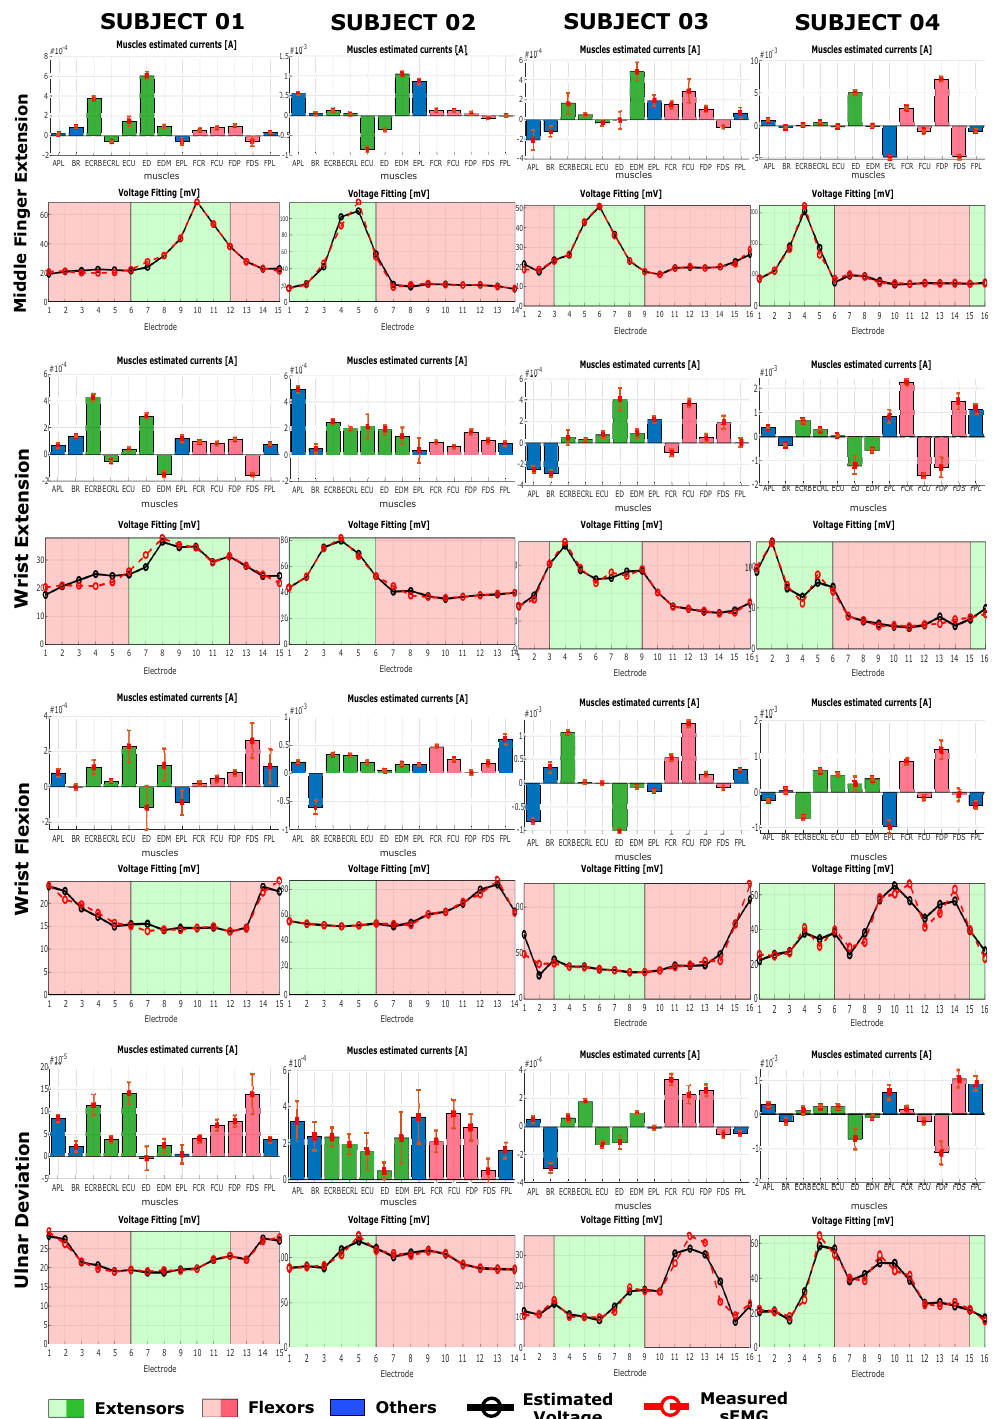
Figure 8. Estimated currents and voltage fitting on the electrodes space for all the tasks considered at 25% of MVC. Each bar represents the average current estimated for a muscle for 11 repetitions. The bar is coloured in green for extensors and in red for flexors. Muscles that are not mainly involved in the considered movements according to anatomy are colored in blue. On the electrodes space, the measured sEMG is represented with a red dotted line, whereas one example of the estimated value is represented with a solid black line. The background color is green for electrodes over the posterior side of the forearm (extensors) and is red for electrodes over the anterior side of the forearm (flexors). For further information on the meaning of the abbreviation of the muscles and their position refer to Figure